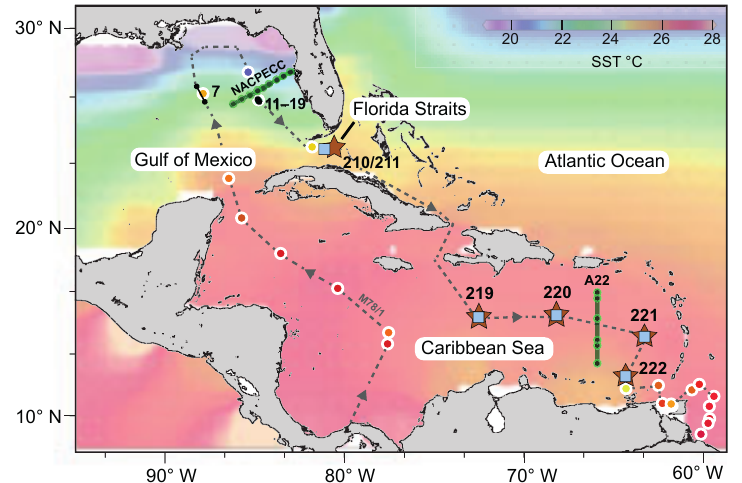
Figure 1. Sea surface temperature (SST) chart of the subtropical west Atlantic (Caribbean Sea, Gulf of Mexico and Florida Straits) showing sampling locations for living planktic foraminifers (Table 1). Brown stars indicate the multiclosure net (MSN) samples and CTD stations (RV Meteor cruise M78/1). Black dots and lines indicate plankton filter samples (PF, M78/1). Blue squares indicate surface sediment samples (M78/1 and RV Sonne cruise SO164; see Regenberg et al., 2006; Steph et al., 2009). Green lines and grey dots indicate World Ocean Circulation Experiment (WOCE) transect line A22 (stations 10–15) and North American Carbon Program (NACP) line NACPECC (stations 20–28) (https://cchdo.ucsd.edu/, last access: 21 November 2018). Coloured shading indicates SST illustrated with Ocean Data View (ODV) (Schlitzer, 2009) using World Ocean Atlas 2013 (WOA13) data from January to March (Locarnini et al., 2013). Coloured dots with white outline indicate SST (3.5m water depth) recorded during cruise M78/1 with the shipboard thermosalinograph (Schönfeld et al., 2011; Sect. S1). The grey dashed line indicates the cruise track of RV Meteor cruise M78/1 in February and March 2009. Black numbers indicate MSN and PF stations (see Table 1).